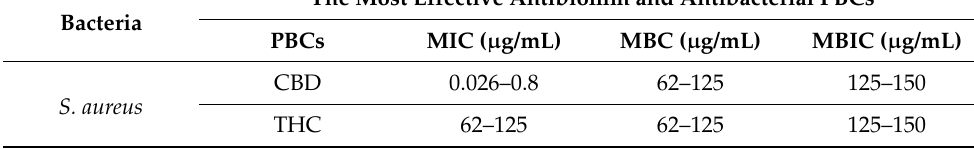
Table 1. The most effective antibiofilm and antibacterial PBCs for targeted treatment towards defined pathogen